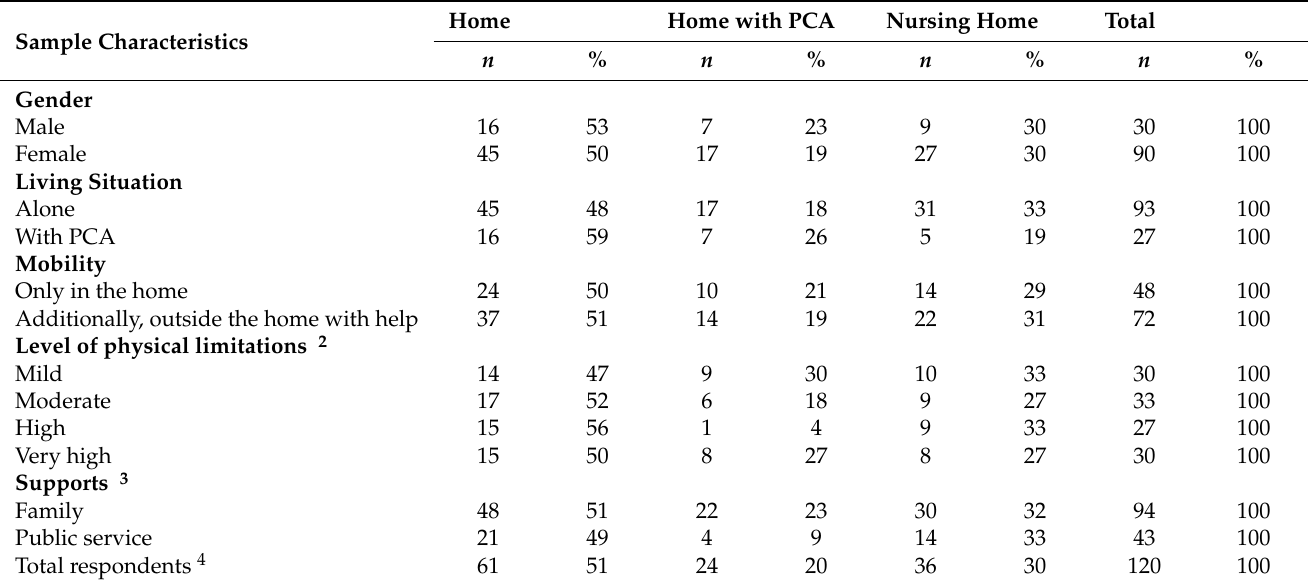
Table 5. Future housing solutions 1 and gender, living situation, mobility and supports received ( n ; %).